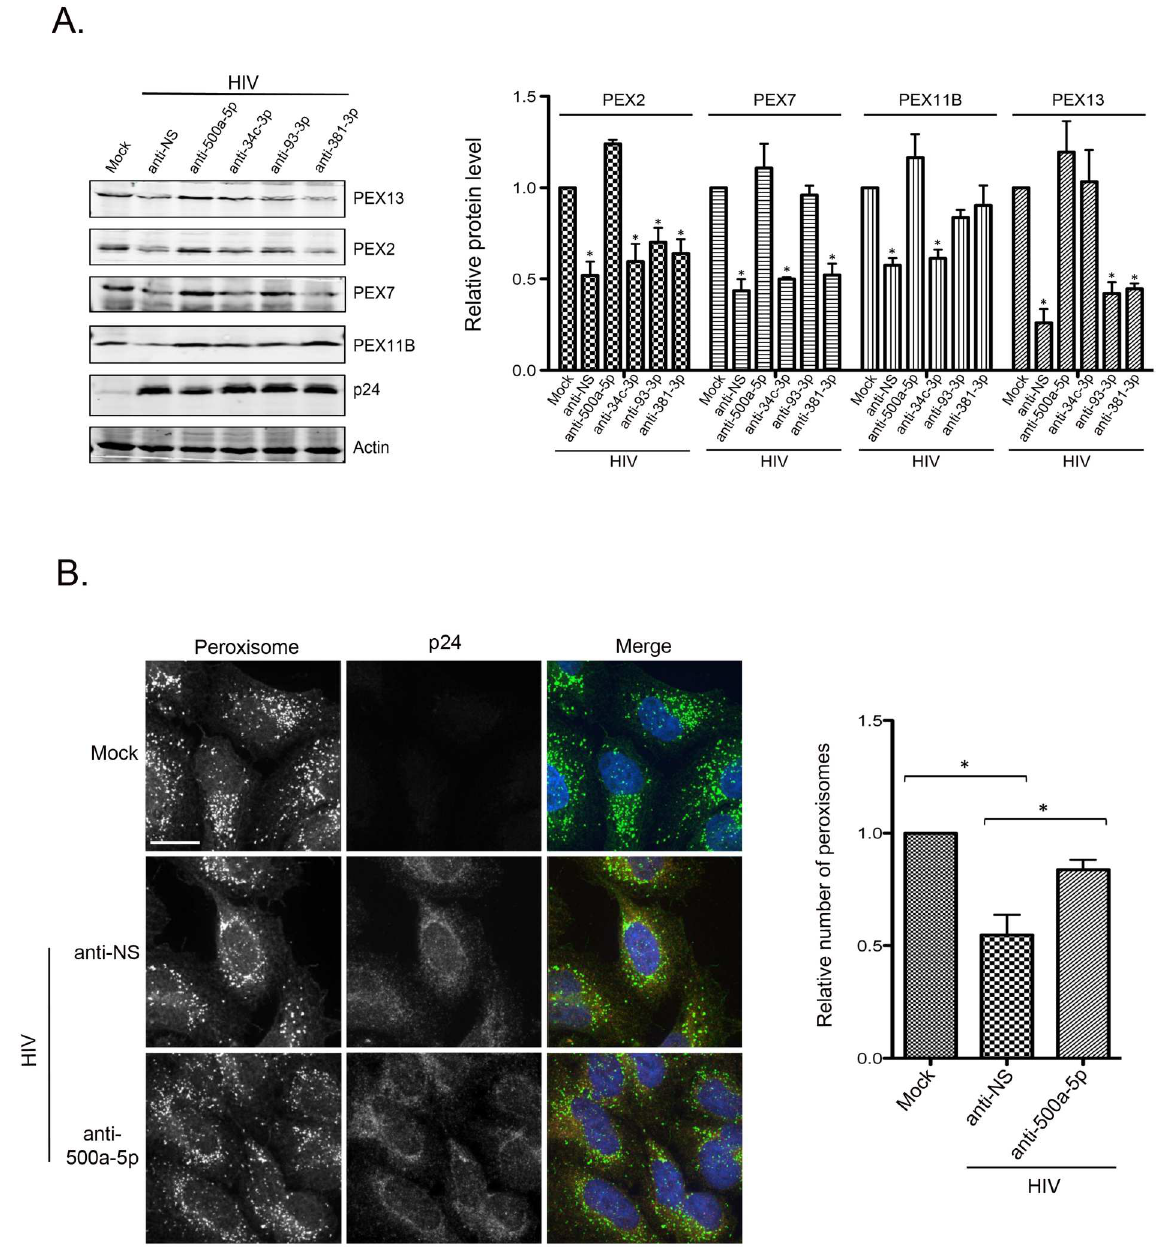
Fig 7. HIV-induced loss of peroxisomal proteins and peroxisomes is abrogated by blocking the function of miR-500a-5p. A. HEK293T cells were transfected with a plasmid encoding HIV-1 provirus (pYU2) for 12 hours after which cells were transfected with anti-miRs that are complementary to the HAND-associated PEX-specific miRNAs. Cell lysates were collected36 hours later and then subjectedto immunoblot analyseswith antibodiesto PEX2, PEX7, PEX11B, PEX13, HIV-1 p24 and actin. The relativelevels of peroxisomal proteins (normalized to actin) from 3 independentexperiments were determined. Error bars represent standard error of the mean. * p < 0.05.B. Hela CD4+ cells (clone 1022) were infected with HIV-1 (MOI = 10) for 16 hours and then transfected with anti- miR-500a-5p. Forty-eight hours later, cells were processedfor indirect immunofluorescence and confocalmicroscopy. Peroxisomes were detected with a rabbit polyclonal antibody to the peroxisomal targeting signal SKL and donkey anti-rabbitIgG conjugated to Alexa Fluor 488. HIV-infected cells was detected with a mouse monoclonal antibody to HIV-1 p24 and donkey anti-mouse IgG conjugated to Alexa Fluor 546. Nuclei were stained using DAPI. Images were obtainedusing spinningdisc confocalmicroscopy. Size bar is 10 μ M. The relative numbers of peroxisomes (SKL-positive structures) in mock and HIV-infected cells transfected with or without anti-miR-500a-5pwere determined using Volocity image analysessoftware. The averagenumbers of peroxisomes/cell were calculatedfrom three independent experiments in which a minimum of 10 cells for each sample were analyzed. * p < 0.05.